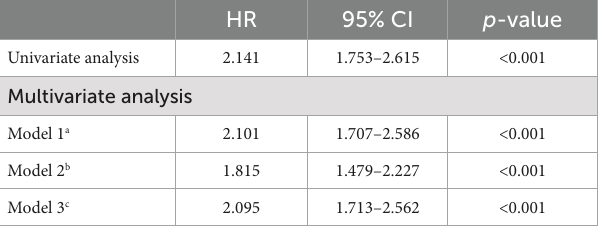
TABLE 2 Risk of hospitalization associated with apathy in unadjusted and adjusted Cox model. HR 95% CI p -value